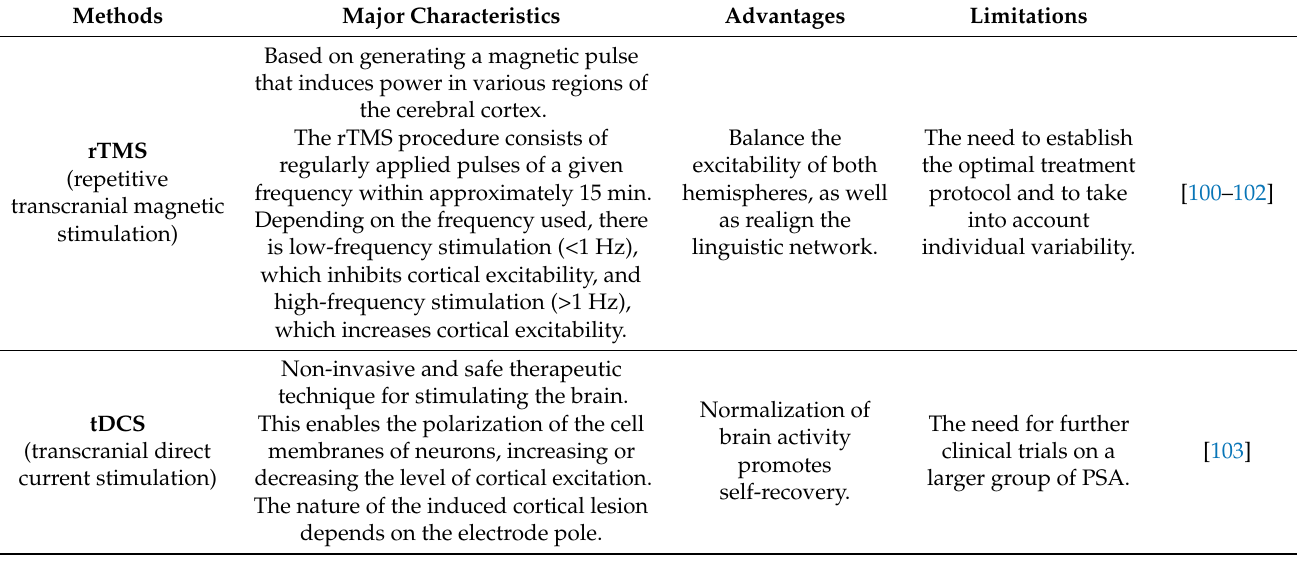
Table 4. Summary of non-invasive brain stimulation in post-stroke aphasia